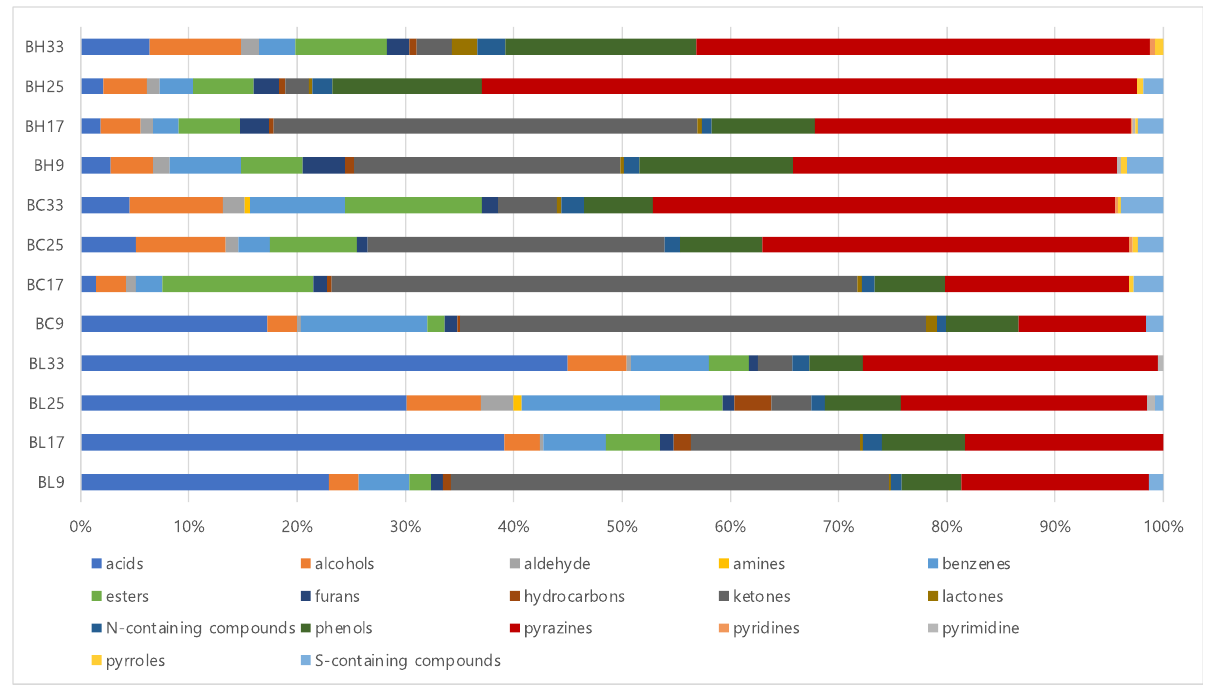
Figure 1. The composition of metabolites in B. subtilis samples based on volatile metabolites (BH, high level of BAs- producing strain; BL, low level of BAs-producing strain). This study applied PLS-DA to investigate differences in the metabolic profiles derived from different B. subtilis strains. Figure 2 shows PLS-DA score plot based on volatile metabolite profiles in BL and BH according to cultivation times. The PLS-DA model explained 41.2% of the total variance (PLS [1] and PLS [2] dimensions). The parameters of the cross-validation modeling yielded R 2 Y = 0.990 and Q 2 Y = 0.973. Through the permutation test, values of R 2 = 0.299 and Q 2 = − 0.361 were obtained. In order to determine the significant metabolic differences between B. subtilis strains, a total of 29 main variables contributing to the PLS [1] and PLS [2] dimensions were selected on the basis of a threshold of 1.0 for the variable importance in the projection (VIP). The selected volatile metabolites could been considered as metabolic indicators representing BH or BL. In particular, long- chained fatty acids, including hexadecanoic acid, dodecanoic acid, and octadecanoic acid, were BL-specific metabolites, while, pyrazines, including 2,3,5-trimethylpyrazine, 3-ethyl- 2,5-dimethylpyrazine, 2-ethenyl-3,5-dimethylpyrazine, 2,5-dimethylpyrazine, 2-ethyl-5- methylpyrazine, 2,5-dimethyl-3-(3-methylbutyl)pyrazine, and 2-methylpyrazine, were selected as BH-specific